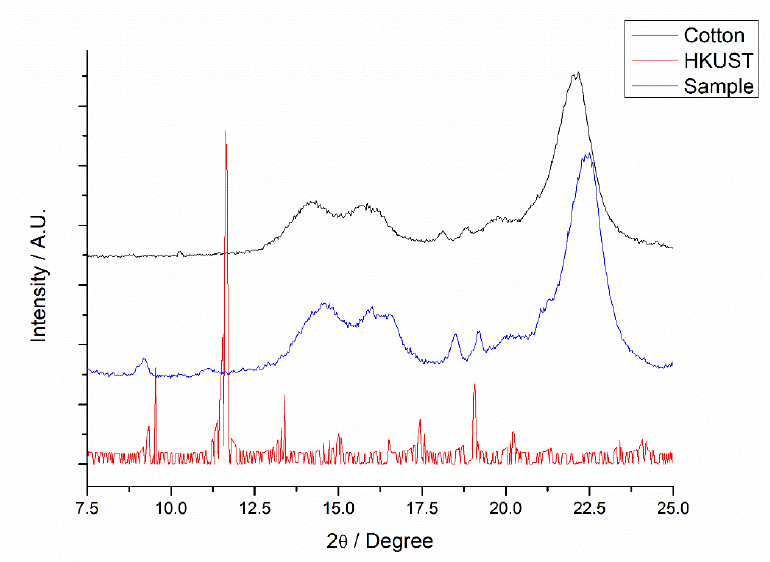
Figure 2. XRD patterns of fabric (-Cotton), treated fabric 2480 (-Sample) and MOF (-HKUST).